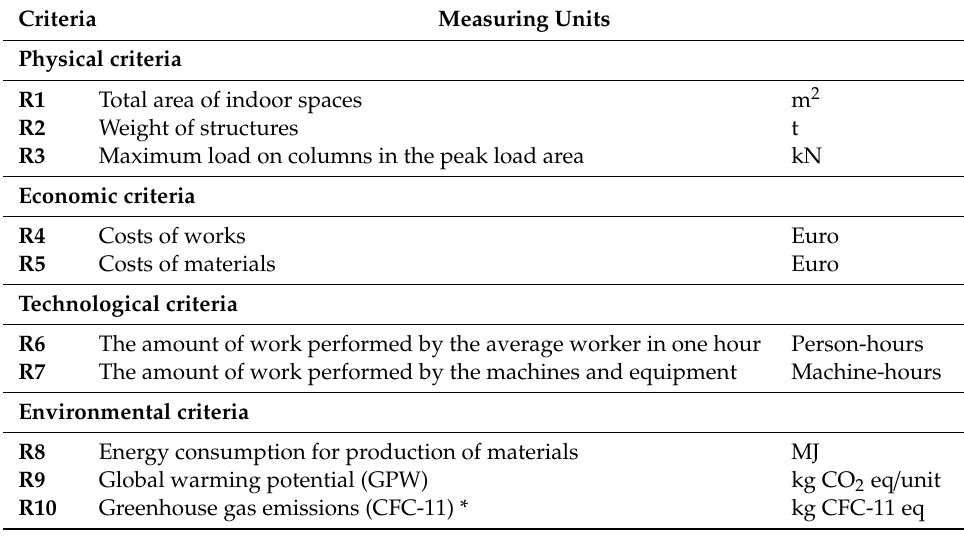
Table 3. Initial set of criteria for the sustainability assessment of alternative structural solutions of case building.